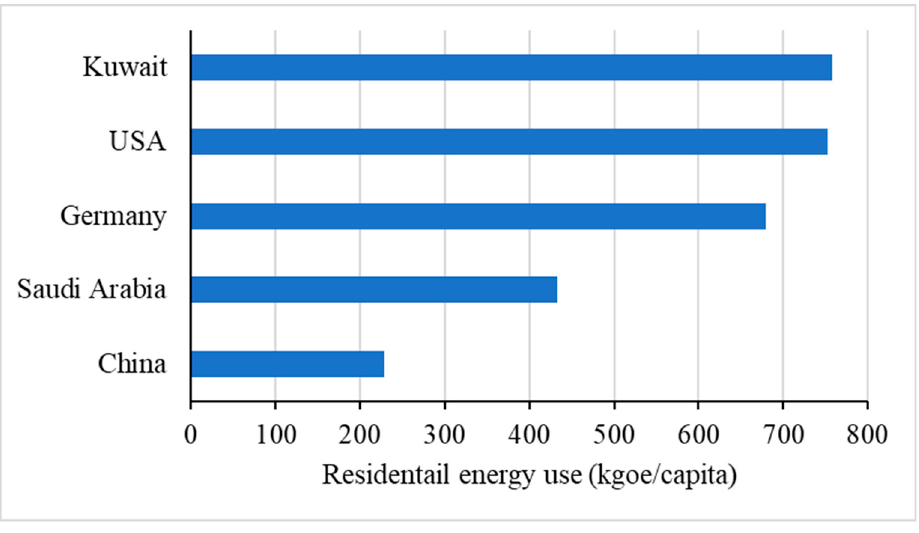
Figure 2. Residential energy use per capita in 2014 (kg of oil equivalent per capita) [3].